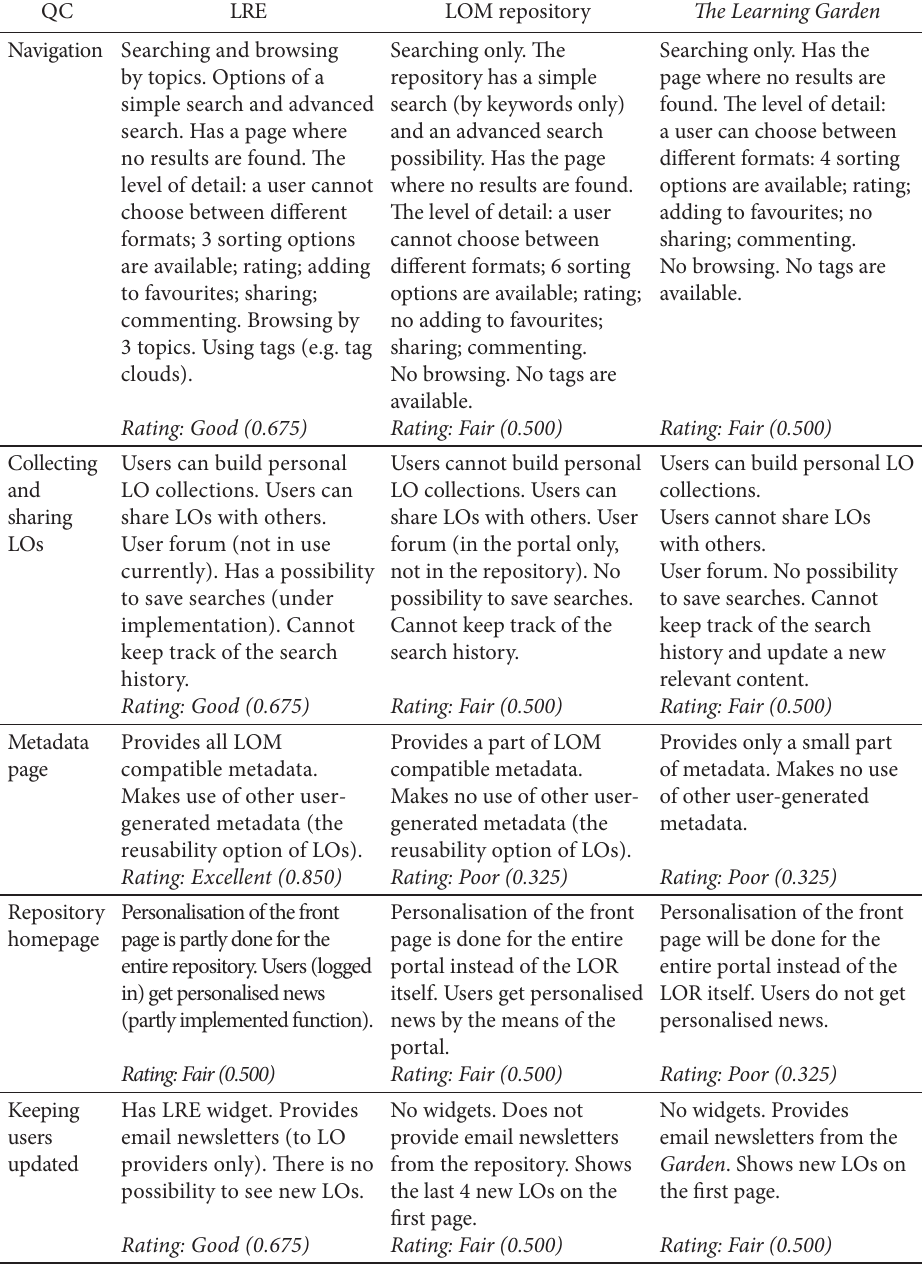
Table 3. Ratings (values) of the quality-in-use criteria of LORs QC LRE LOM repository The Learning